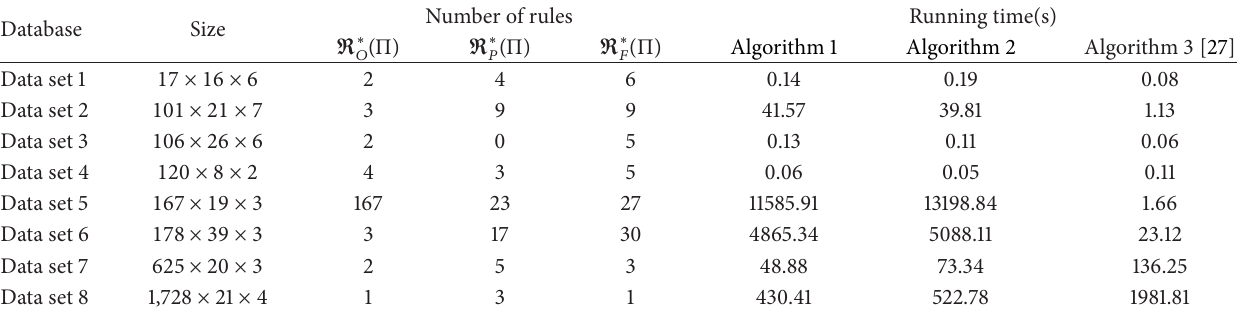
Table 4: A contrast between the proposed rule acquisition algorithms and the existing one in terms of the running